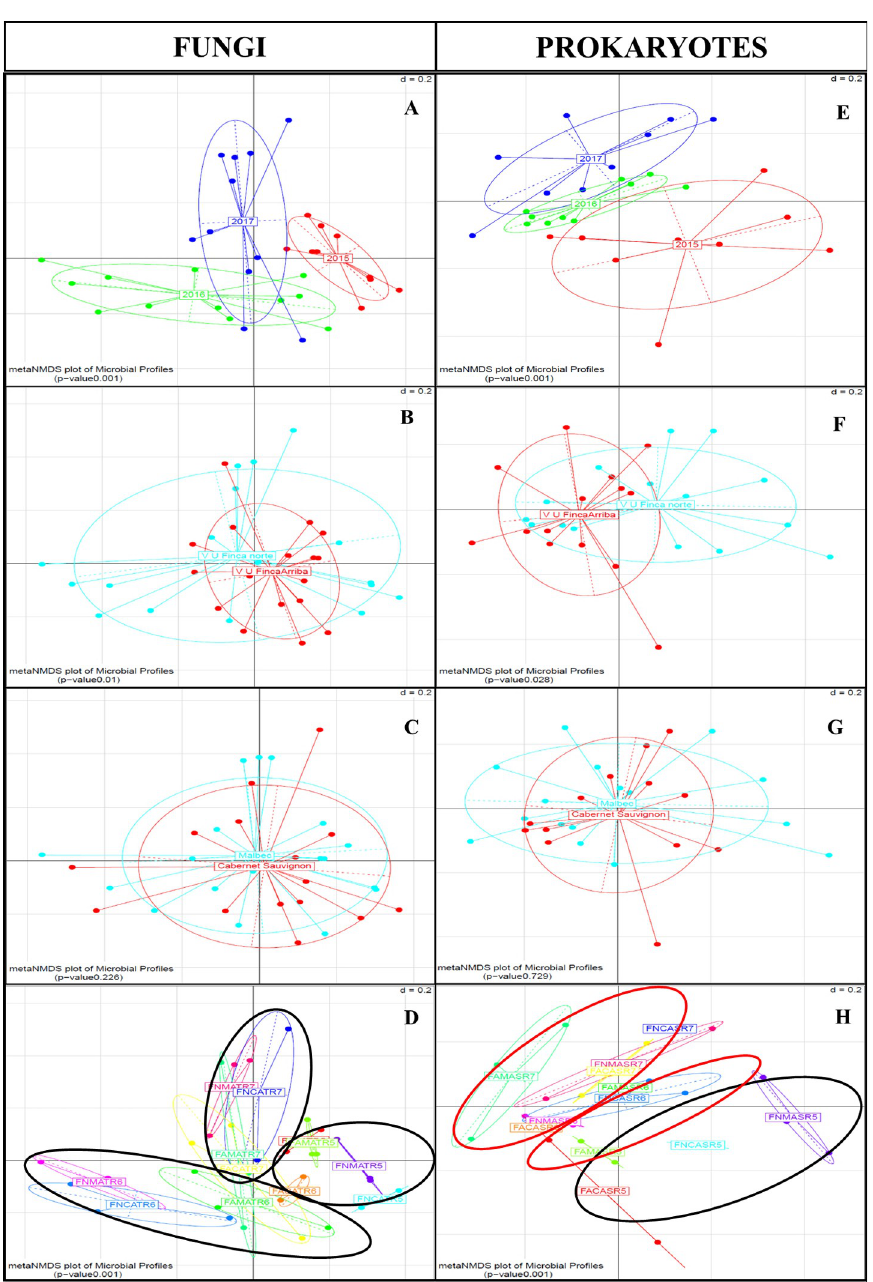
Fig 2. Non-metric Multidimensional Scaling (NMDS) of microbial communities by vintage, location, cultivar and plots. (A) Fungal communities grouped according to the vintage, (B) location, (C) cultivar and (D) plot. (E) Prokaryotic communities grouped according to the vintage, (F) location, (G) cultivar and (D) plot. Samples were grouped at 20% of dissimilarity distance using the generalized Unifrac metric. P values to observe significant difference between communities were obtained through a PERMANOVA test, and are represented on the left hand corner of each figure.